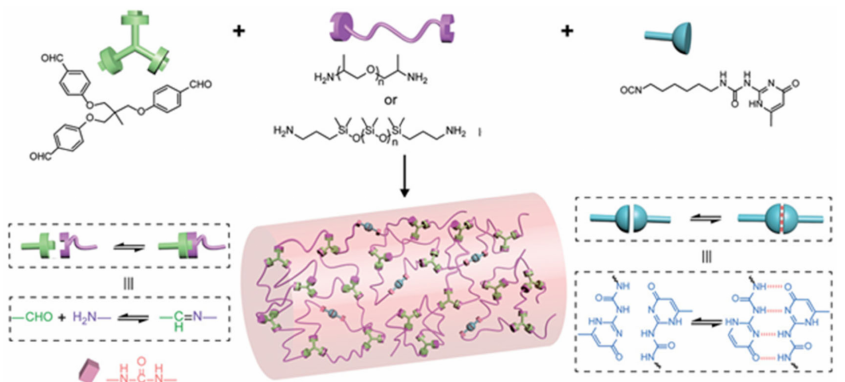
Figure 36. Chemical structure of SHPs cross-linked by dynamic imine bonds and UPy. Reproduced from [189] with permission from John Wiley and Sons.